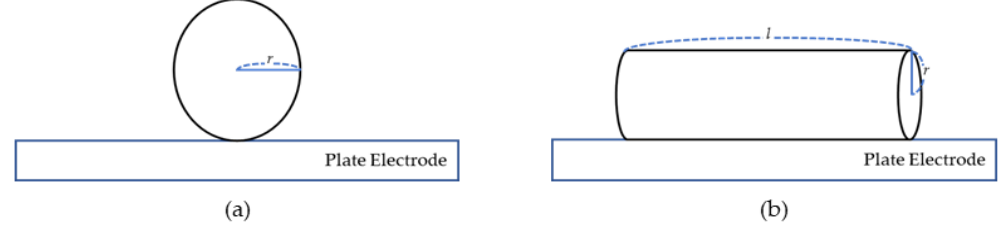
Figure 5. Simplified particle shapes: ( a ) A glass particle, and ( b ) a copper particle.